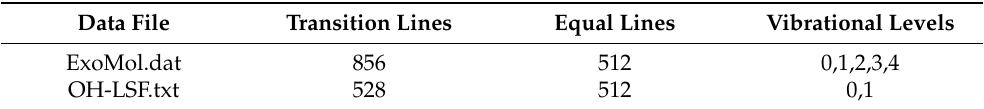
Table A1. Comparison of ExoMol-OH.dat and OH-LSF.txt line strengths in the wavelength range from 305.17 nm to 321.83nm in the experimental data OH100micros.dat.